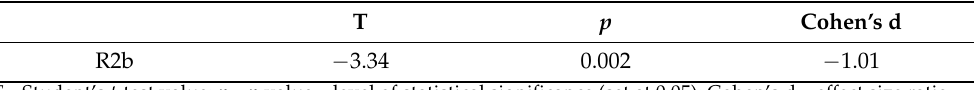
Table 3. Results of ANOVA analysis of significance of Within Subjects Effects differences in SD of COP displacements. F p η 2 p task